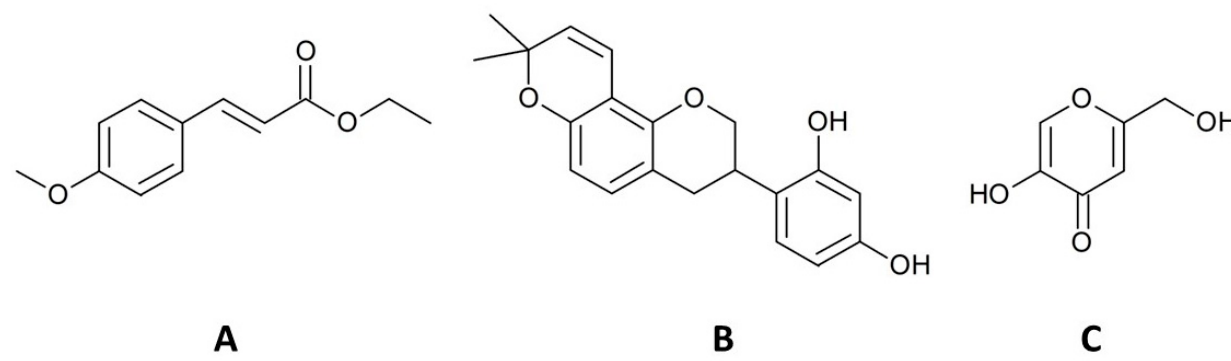
Figure 1. Total chemical component analysis of remedy extracts, presented in a pile chart (100%) using GC–MS. ( A ) Metabolites present in 80% ethanol extract. ( B ) Metabolites present in ethyl ace- tate extract.